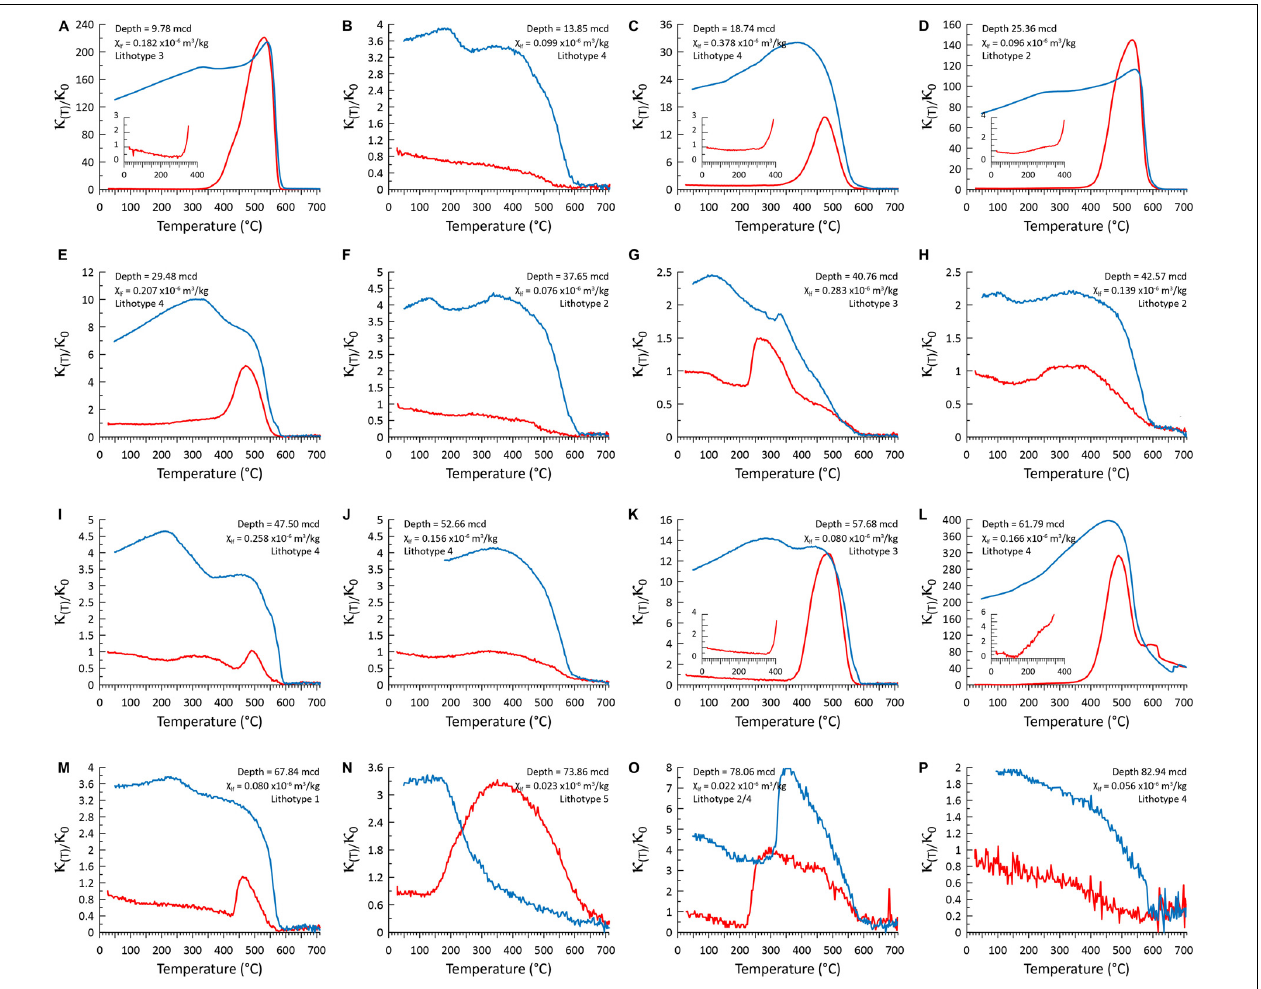
FIGURE 3 | High temperature magnetic susceptibility (HTMS) of 16 select discrete samples. MS was measured during heating from room temperature to 700 ◦ C (red curves) and on cooling to 50 ◦ C (blue curves). Data at each temperature [ κ ( T ) ] are presented normalized to the MS value at the beginning of the experiment κ 0 and are shown alongside the sample depth, room temperature mass normalized MS ( χ lf ) and the lithotype from which it was sampled ( Figure 2 ). Where variations in the normalized MS data on heating between ∼ 25 and 400 ◦ C are obscured by higher values on cooling (A,C,D,K,L) the ∼ 25 – 400 ◦ C heating curve is provided as an inset. Panel letter identifiers are used consistently across Figures 2 , 4 to aid comparison of samples. Note the general lack of Curie temperatures associated with ferrimagnetic pyrrhotite ( ∼ 320 ◦ C) and/or greigite ( ∼ 350 ◦ C) and the dominance of weakly paramagnetic mineral phases that alter above ∼ 400 ◦ C to produce ferrimagnetic